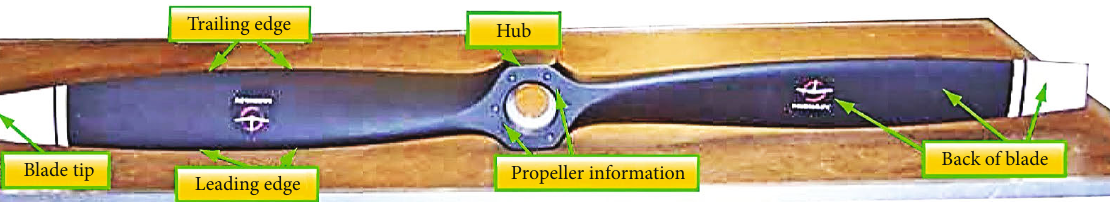
Figure 4: Basic nomenclature of propellers [24].